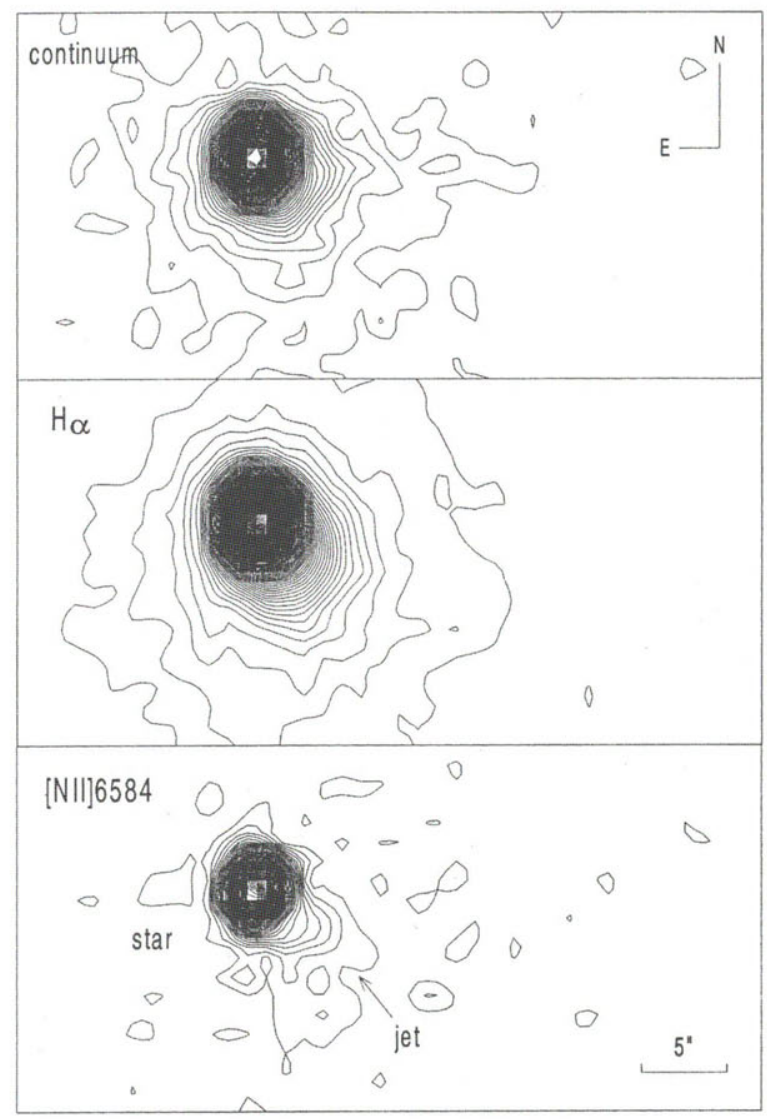
Fig. 2. Restored images of LkHa